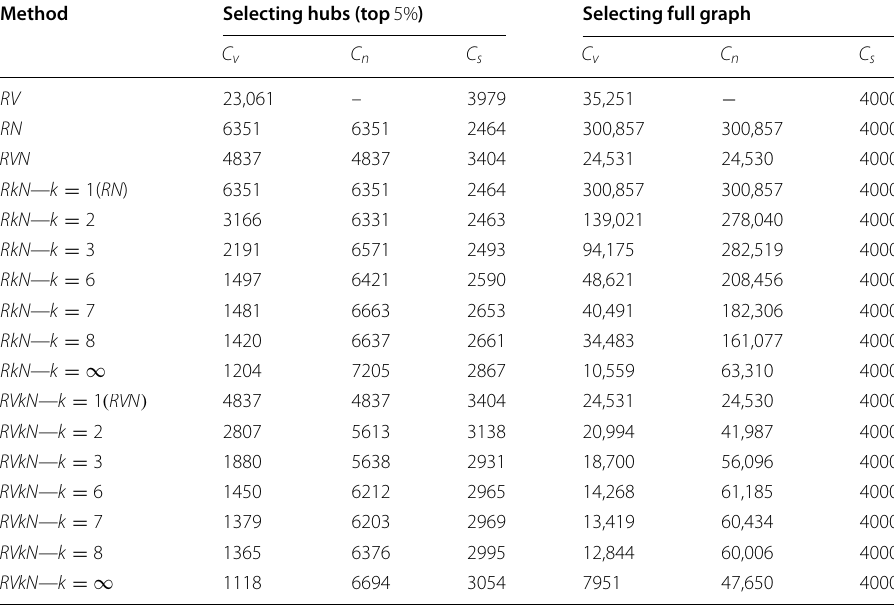
Table 3 An experimental analysis of C v , C n , and C s costs in BA Graphs Method Selecting hubs (top 5%